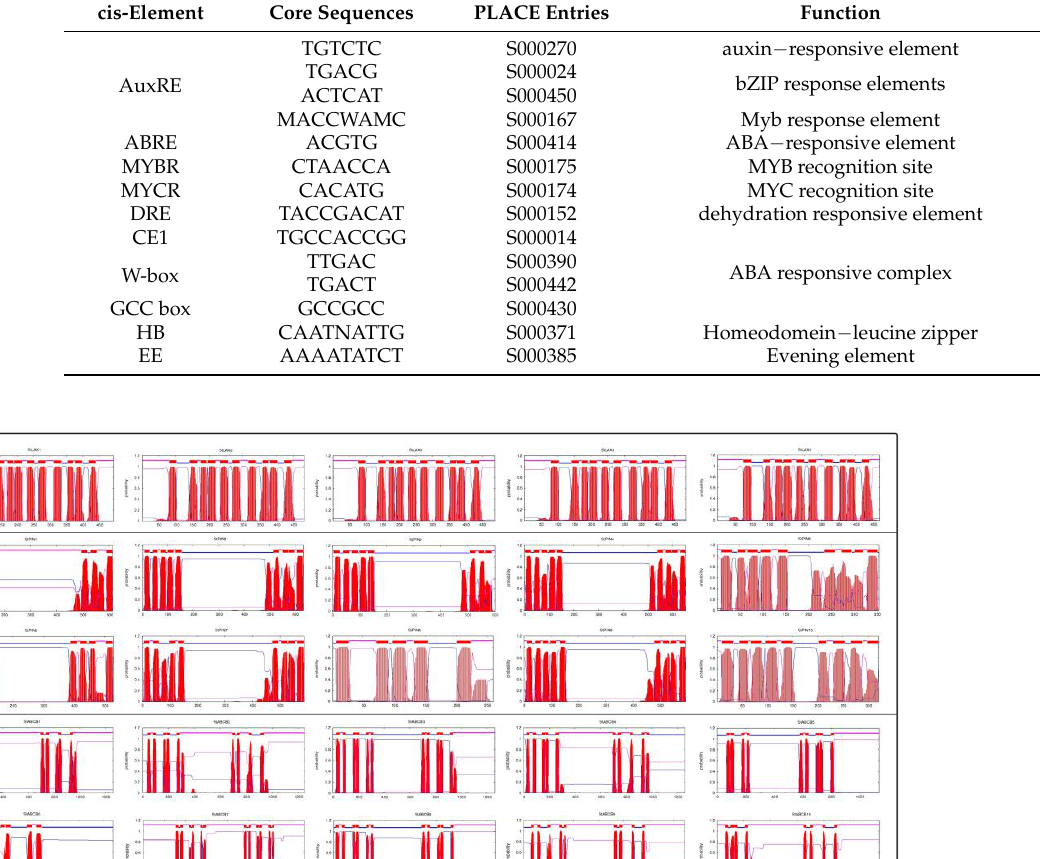
Table A10. PLACE entries of cis −elements within the promoters of auxin transporter genes.